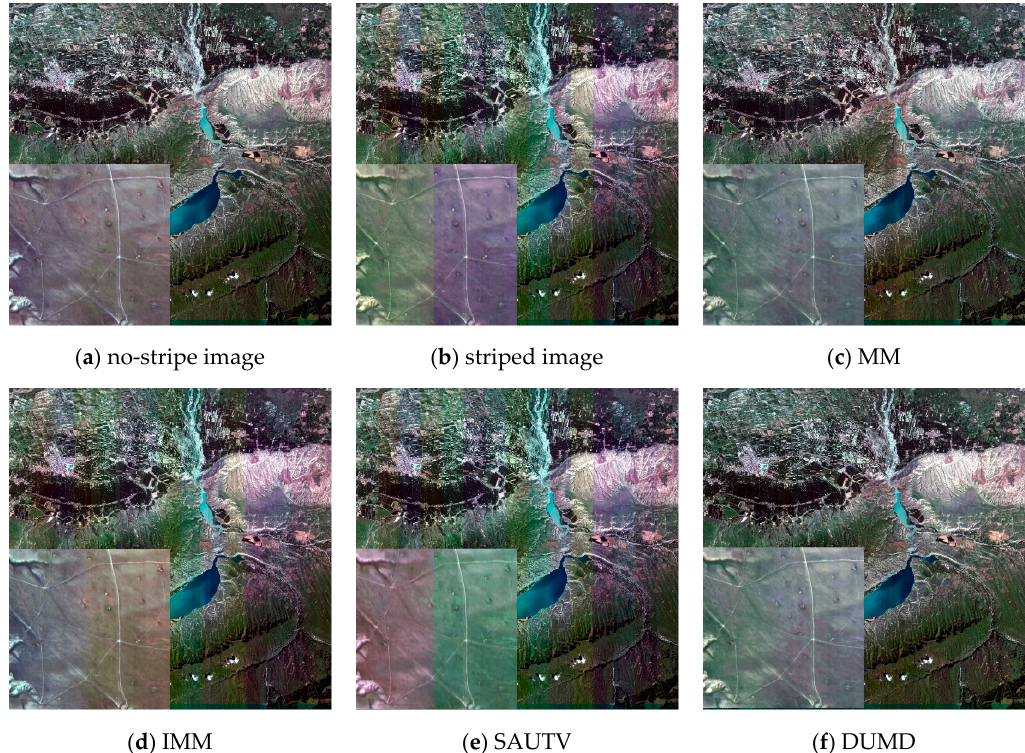
Figure 5. Destriping performance of Data 6 (Ziyuan3-02, ZY3-02). Where ( a ) is the no-stripe image, ( b ) is the striped image, ( c ) is the destriped image processed by MM, ( d ) is the destriped image processed by IMM, ( e ) is the destriped image processed by SAUTV, ( f ) is the destriped image processed by DUMD.